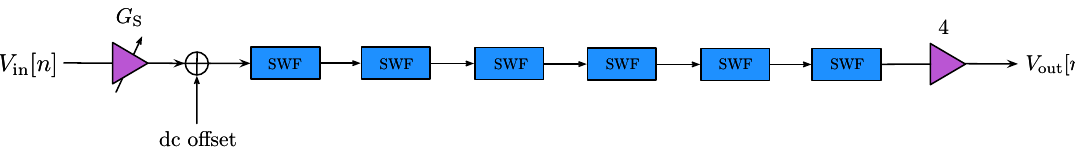
Figure 16. Block diagram representation of the Serge middle VCM. Blocks labeled “SWF” indicate the Serge wavefolder